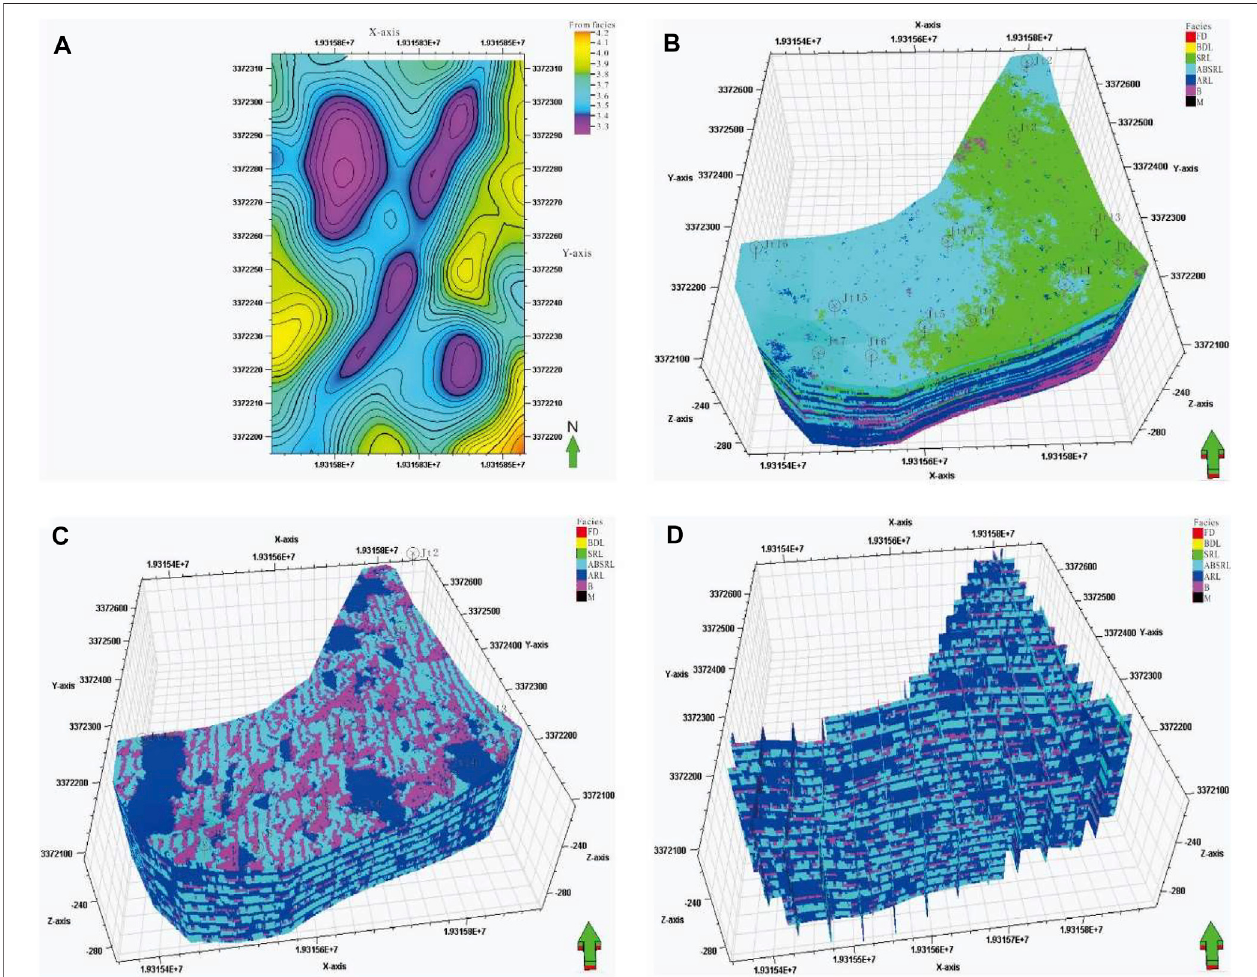
FIGURE 13 | 3-D outcrop modeling of bioherm microfacies, which are restraint by training image pattern. (A) Bioherm training image obtained by SIS, which deposited carbonate lithofacies suddenly to reef core; (B) the SIS lithological modeling; (C) MPS realization; (D) palisade 3-D grids display about the multipoint geostatistics